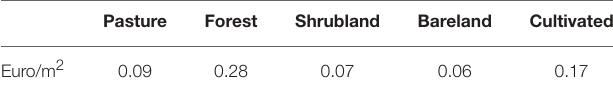
TABLE 1 | Economic values of the selected land cover classes in the Rivo area. Pasture Forest TABLE 2 | Economic values of the selected land cover classes in the B ˘ al ˘ aneasa area. Pasture Forest Shrubland